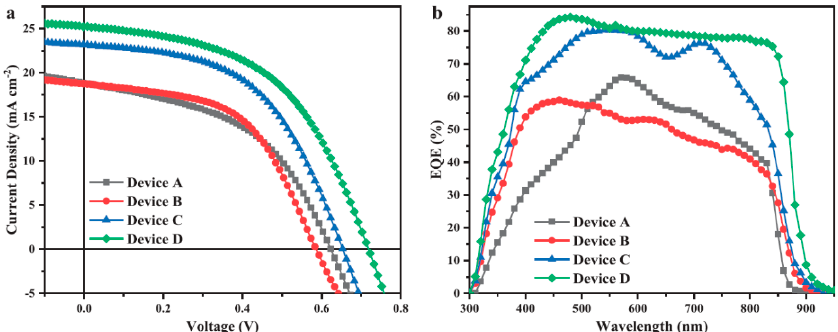
Figure 7. ( a ) J–V curves of CdTe NC solar cells with different structures (Device A: CdTe / Au; Device B: ITO / ZnO / CdSe / CdTe / Au; Device C: ITO / ZnO / CdS / CdSe / CdTe / Au; Device D: ITO / ZnO / CdS / CdSe / CdTe / HTL / Au; ( b ) corresponding EQE spectra. Reproduced with